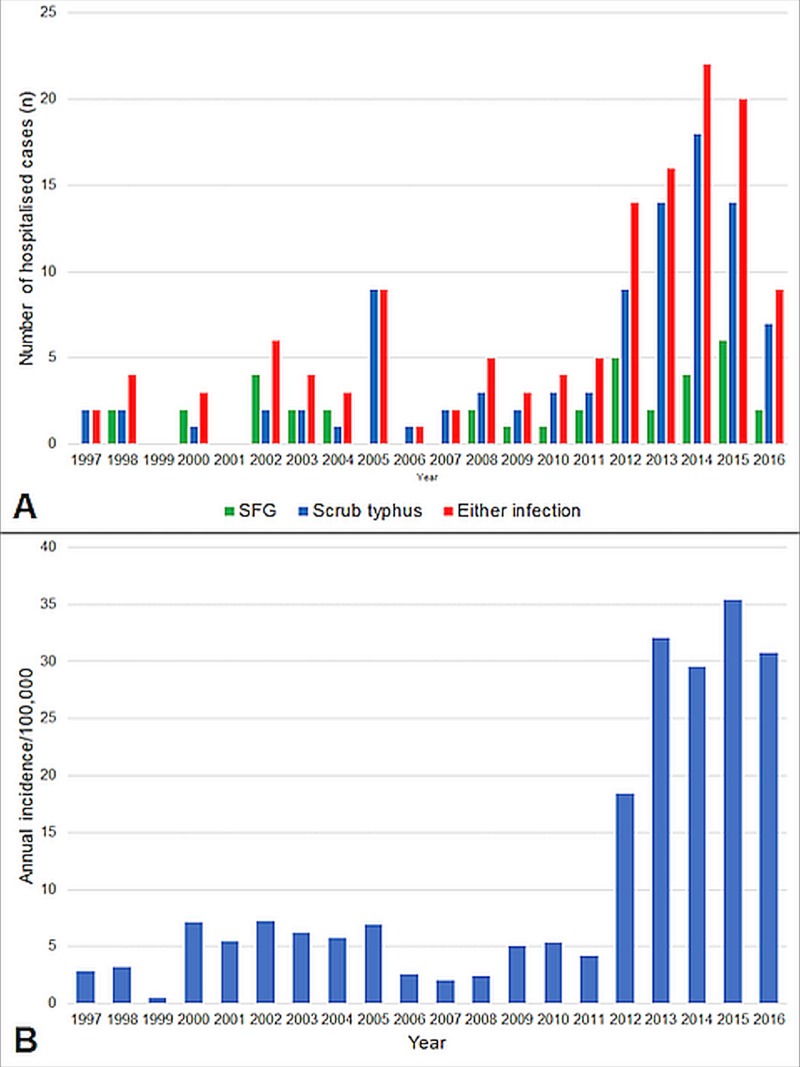
A–The total number of patients with rickettsial infection hospitalized at Cairns Hospital during the study period. B–The annual incidence of rickettsial infections in the Far North Queensland population. Determined using all requests for rickettsial serology from the public health system (positive cases defined using a titre of ≥ 256).